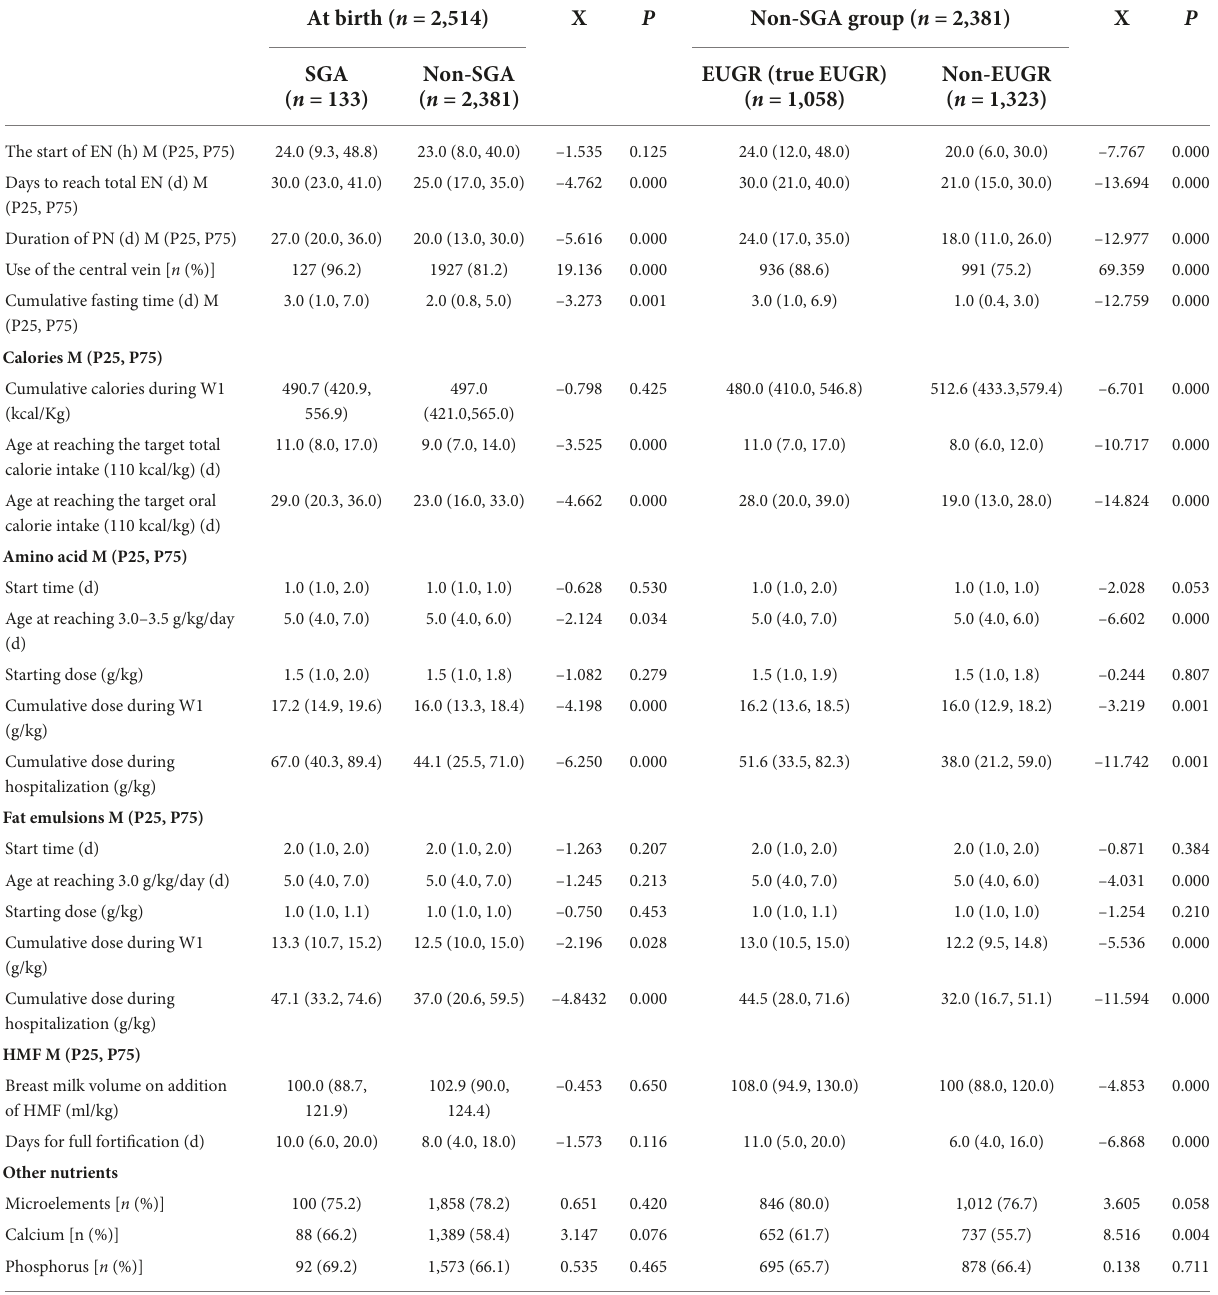
TABLE 3 Comparisons of nutrition-related characteristics between the